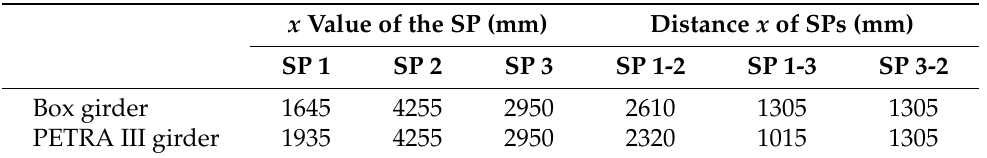
Figure 22. First mode shape of the loaded PETRA III girder considering the support point positions at x = 1645 mm (SP 1), x = 4255 mm (SP 2), and x = 2950 mm (SP 3, at the rear side of the girder) leading to the highest 1st eigenfrequency. The support points were located at heights of 900 mm ( a ), 700 mm ( b ), and 500 mm ( c ). The colours represent the normalised vibration amplitude and the undeformed loaded girder structures are sketched with grey ines. Table 4. Position of the three support points (SPs) at a height of 900 mm that led to the highest 1st eigenfrequency of the magnet–girder assembly.